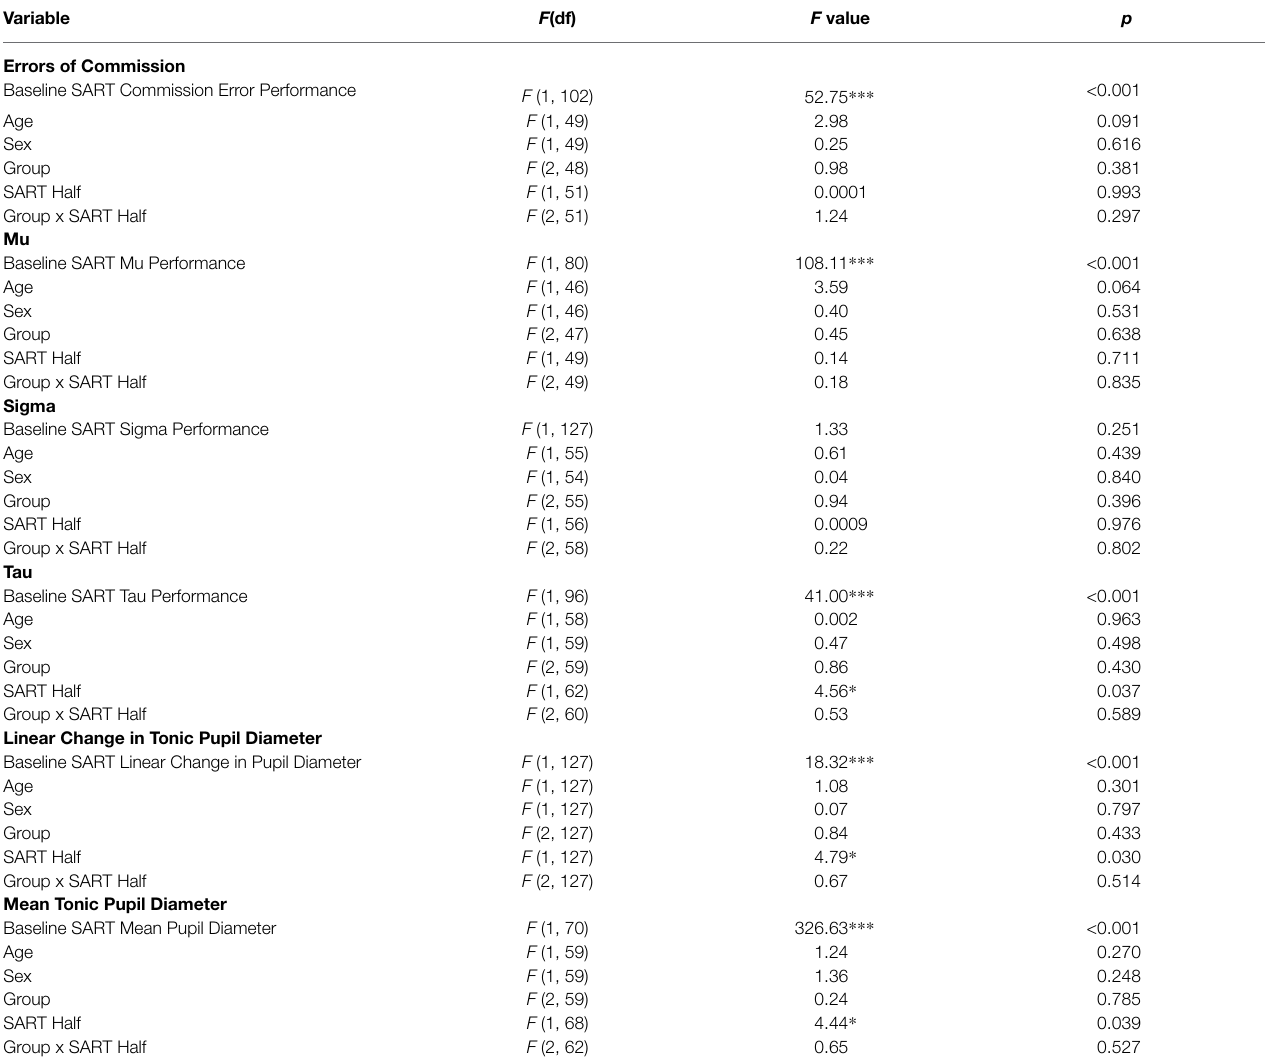
TABLE 3 | Results from the Linear Mixed-Effects Models for Hypotheses 1 and 2 for Study 1.